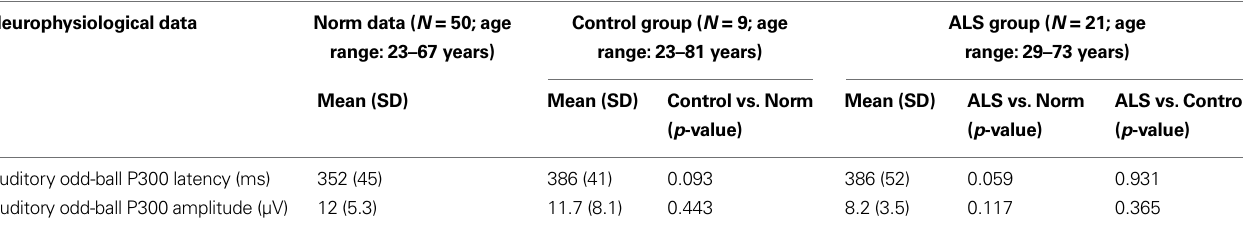
Table 4 | Auditory odd-ball P300 latency and amplitude in Norm data, Control, and ALS; all measures refer to the channel PZ. Neurophysiological